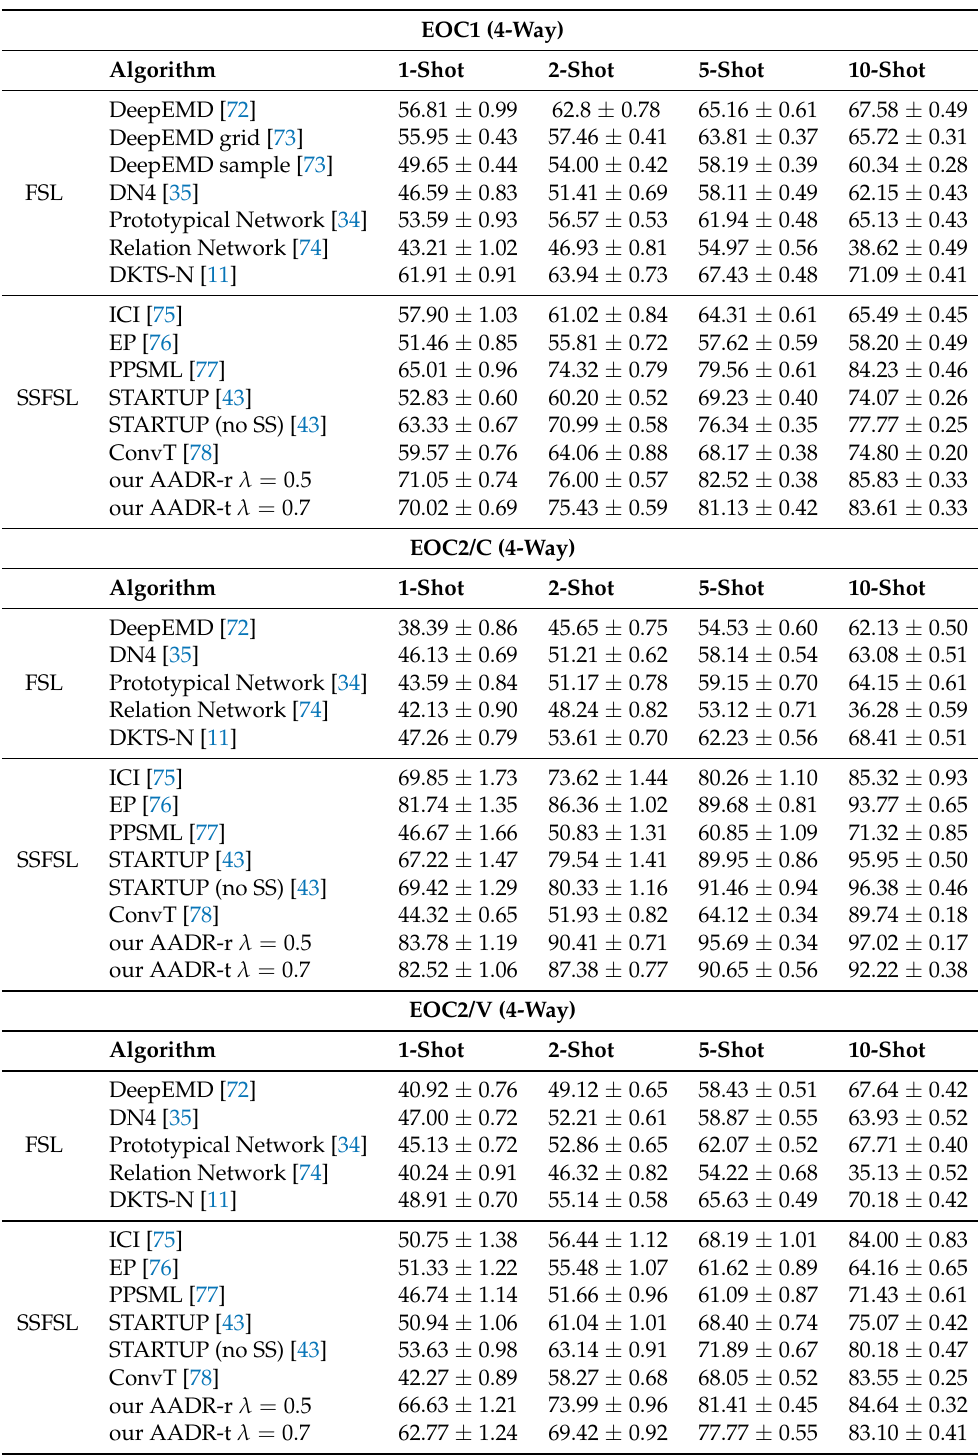
Table 4. Few-shot classification accuracy of